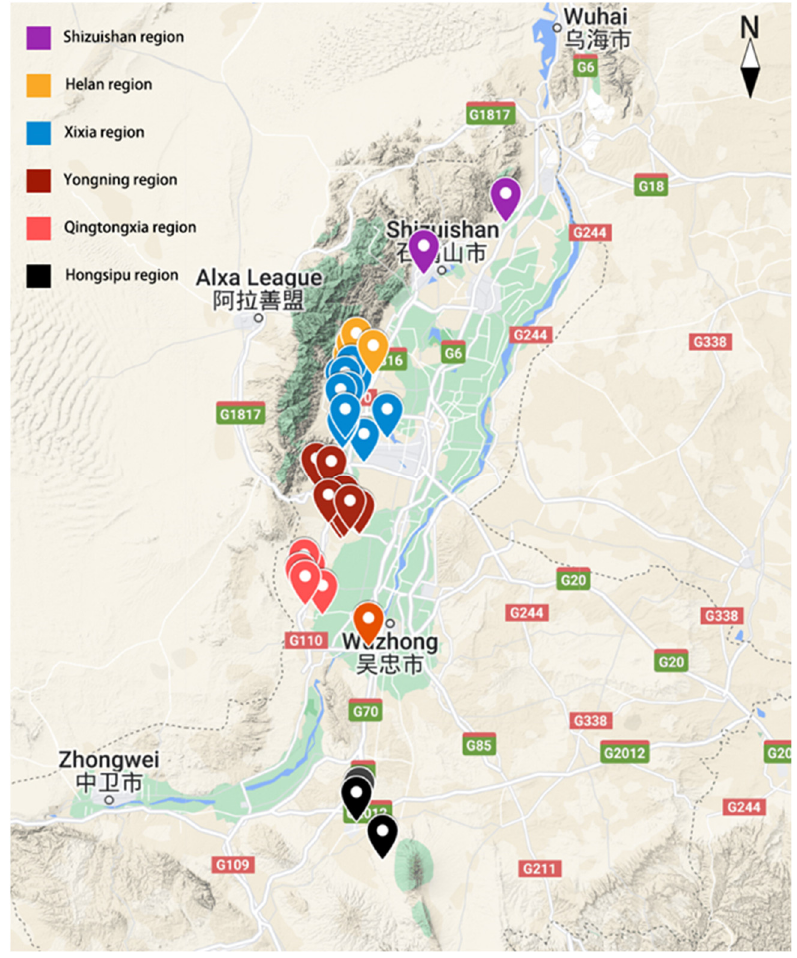
Figure 1. The terrain map of wineries in six sub-regions of the Eastern Foothills of Helan Mountain in Ningxia. The cities on the map are shown in English and Chinese.